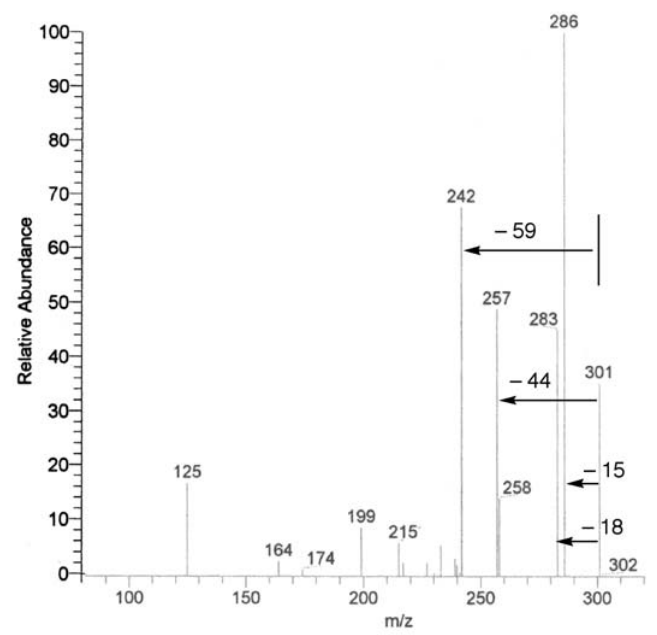
Figure 6 . MS-MS spectrum in negative mode the aglycone hesperetin ( 1 ).